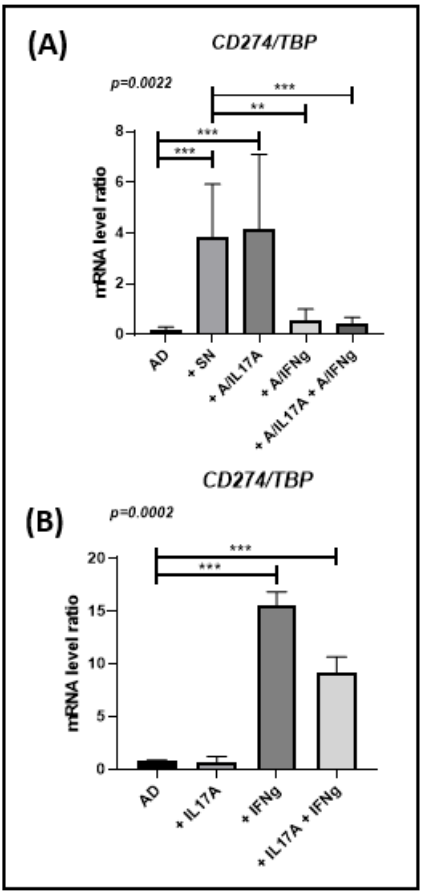
Figure 5. Ob-ASC mediated inflammation results in increasing PDL1 mRNA expression in freshly differentiated adipocytes. Adipocytes were differentiated from ob-ASC in the presence or absence of conditioned media (CM) collected from activated ob-ASC/MNC cocultures, with or without anti-IL-17A, anti-IFN γ , or both mAbs ( A ), or the presence of IFN γ , IL-17A, or both cytokines ( B ). CD274 ( PDL1) mRNA expression levels were measured by RT-qPCR. Results were expressed as a ratio relative to the TBP housekeeping gene. One-way ANOVA with Fisher’s LSD comparison tests were used. ( n = 4 in ( A ), or 2 in ( B )). The p -value shown in the figure are those of ANOVA tests, whereas ***, ** represent p -values <0.001 or <0.01, respectively, of Fisher’s LSD tests.